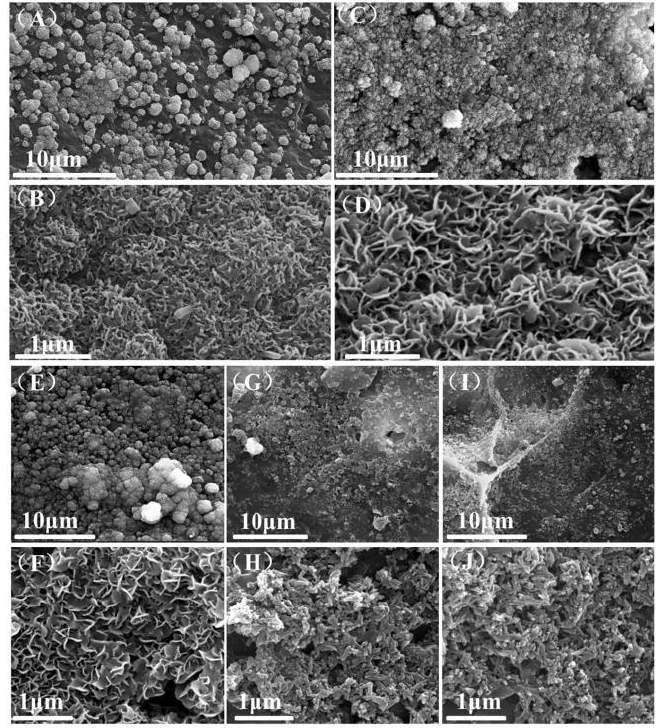
Figure 6. Surface morphologies of the nHA-PBP hybrid membranes with different nHA contents after biomineralization in SBF for 7 days. ( A , B ) 0 wt% nHA, ( C , D ) 20 wt% nHA, ( E , F ) 30 wt% nHA, ( G , H ) 40 wt% nHA, ( I , J ) 50 wt% nHA.